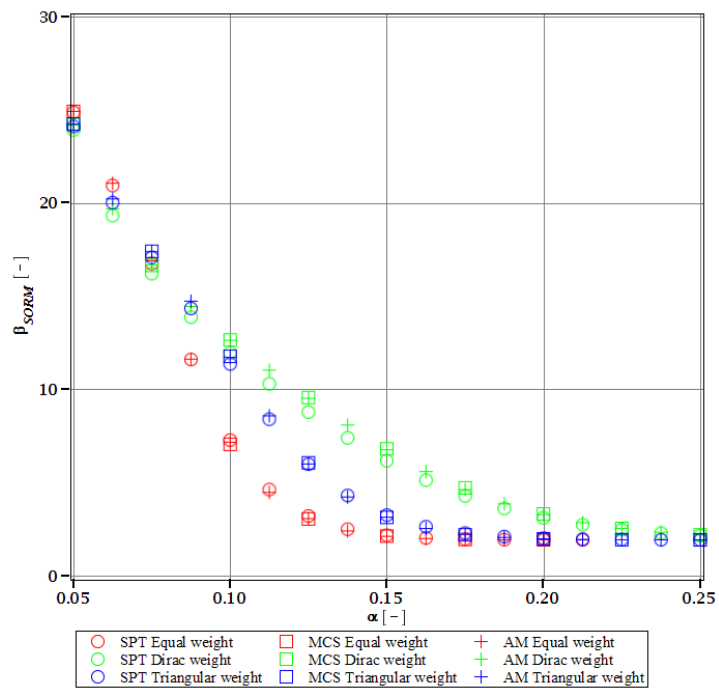
Figure 16. Reliability index of the corrugated I-beam for different types of weights according to the first-order reliability method (FORM) — critical load.